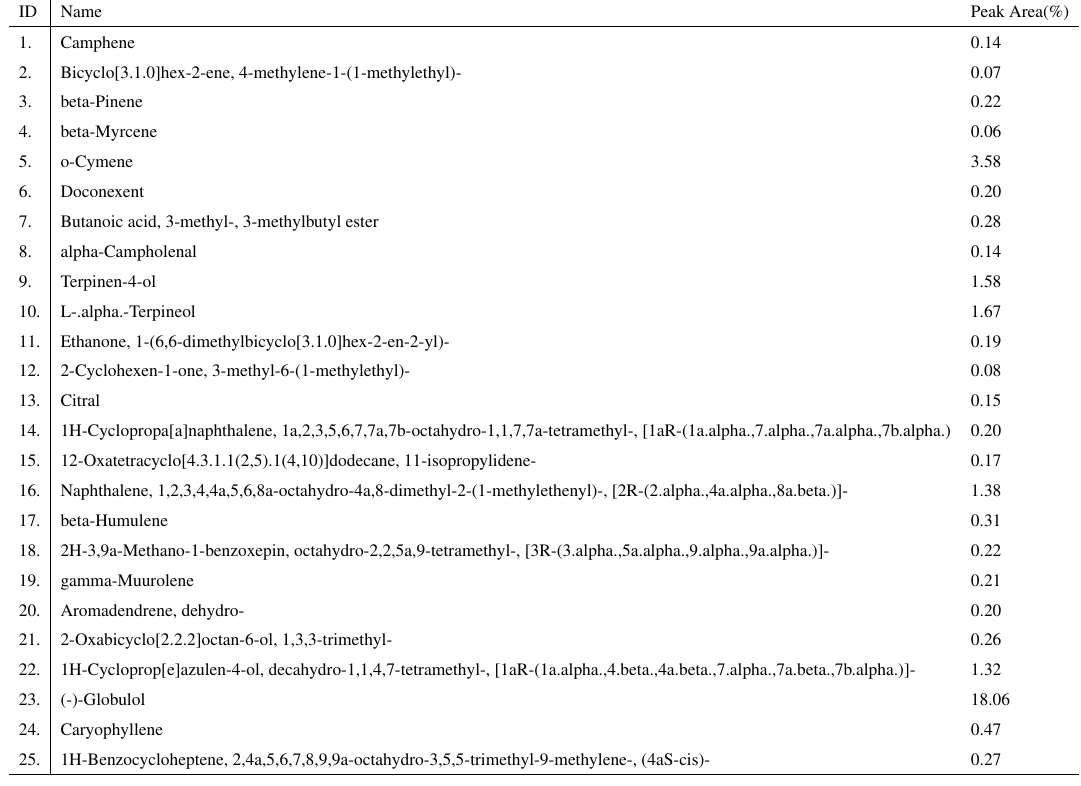
Table 10. Chemical constituents detected appear in the GC-Mass chromatogram in hexane extract of Kafure leaves and area percentage of